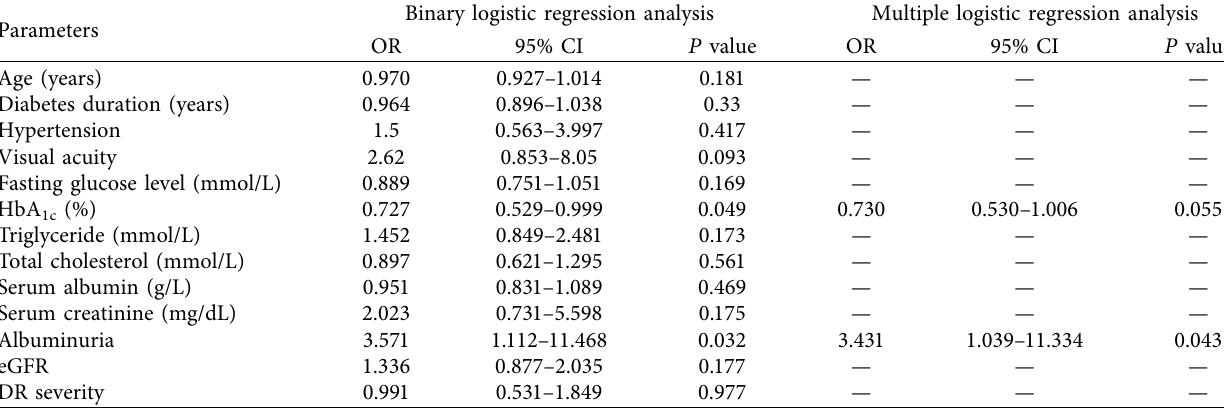
Table 2: Correlating factors for presence of subretinal fuid in patients with diabetic macular edema. Parameters